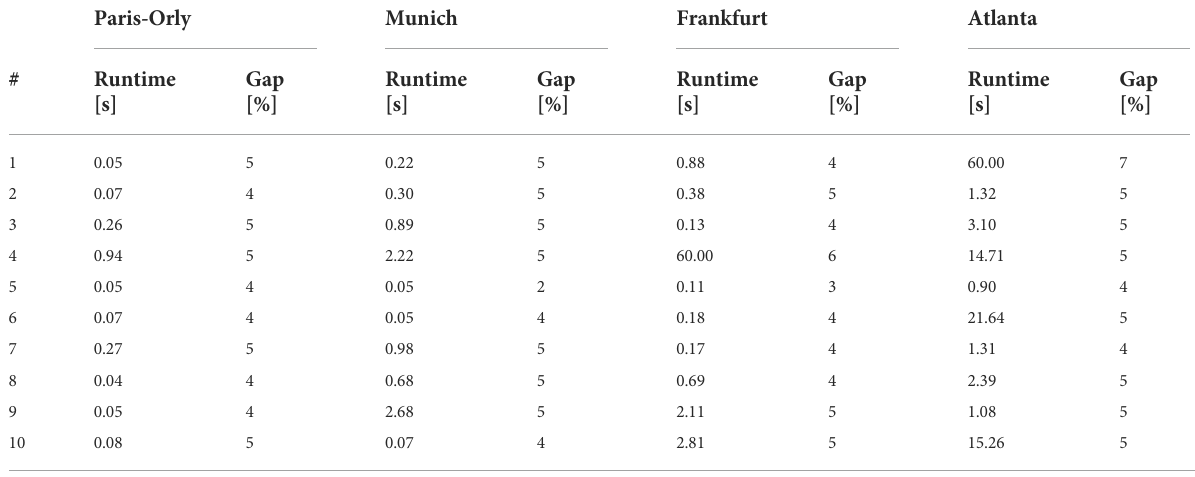
TABLE 4 Solver runtimes in seconds and corresponding branch-and-bound gaps with a prede fi ned 5% gap and time budget of 60 s. Paris-Orly Munich